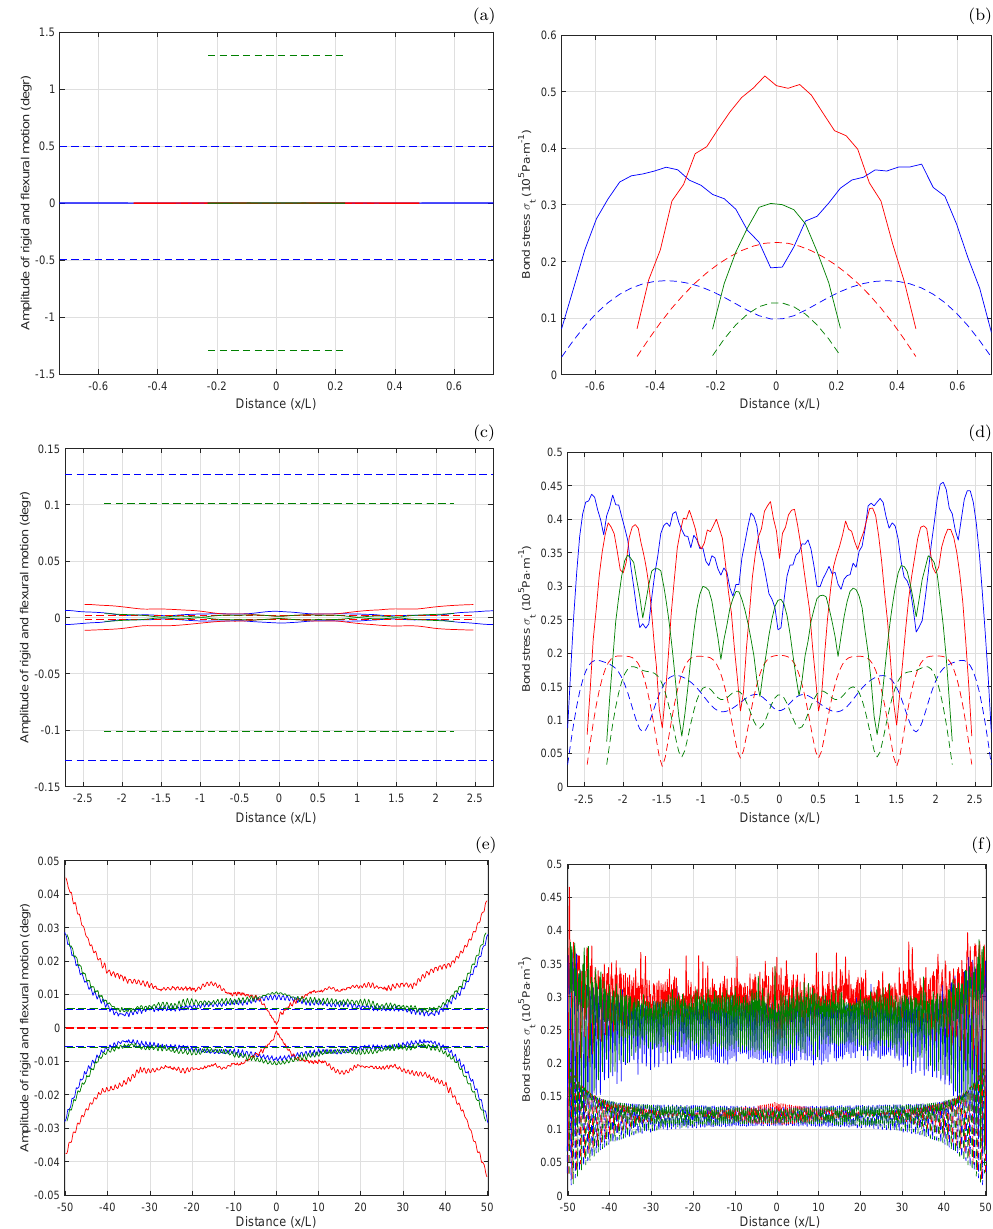
Figure 12. Results of 1-D simulations of sea ice response to waves (without breaking): tilt of the grains (a, c, e) and stress acting on bonds (b, )L (green), n 0 L (red) and (n 0 + 1 )L (blue); n 0 = 1 in (a, b) , n 0 = 5 in (c, d) , and n 0 = 100 in (e, f) . d, f) , for floe lengths equal to (n 0 − 1 2 2 In all cases, both ends of the floe could move freely (see text). The distance along the floes is measured relative to the floes’ centers. In (a, c, e) , continuous lines show the range of variability (i.e., the minimum and maximum values recorded during a simulation) of the flexural components of the floe’s motion; analogously, the dashed lines show the range of variability of the rigid motion. In (b, d, f) , the continuous and dashed lines show the maximum and the standard deviation of the stress, respectively. Note different ranges of the vertical axes in the panels. Note that in (a) , the dashed and continuous red lines cannot be distinguished due to very small